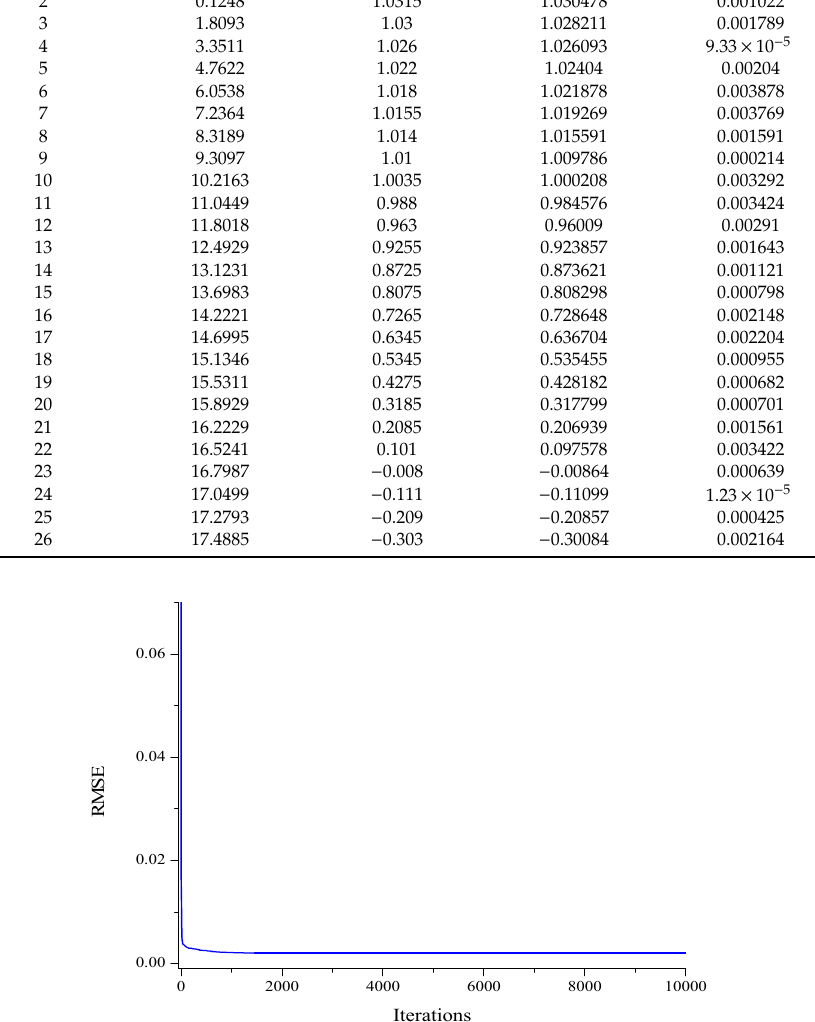
Figure 15. Convergence curve for the double-diode module.